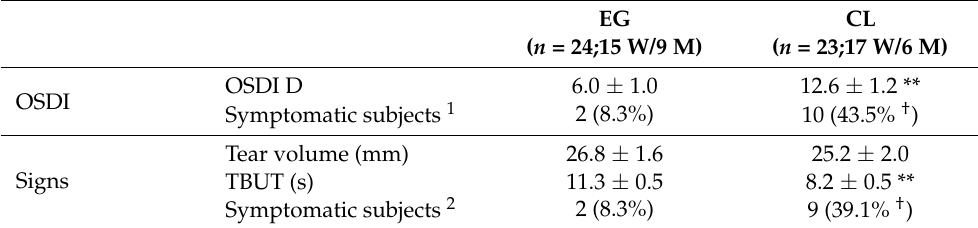
Table 4. Classification of EG and CL wearers as symptomatic subjects depending on the OSDI total score values or the presence of clinical dry eye signs (reduced tear volume and/or